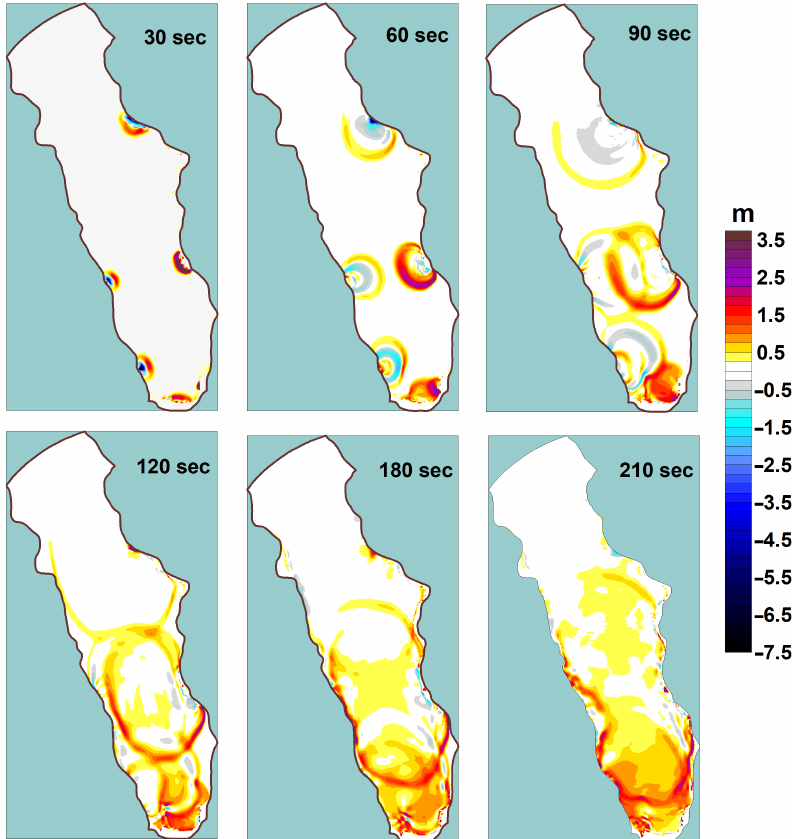
Figure 4. Temporal evolution of the basic experiment BE-3 with activation of the six landslides simul-